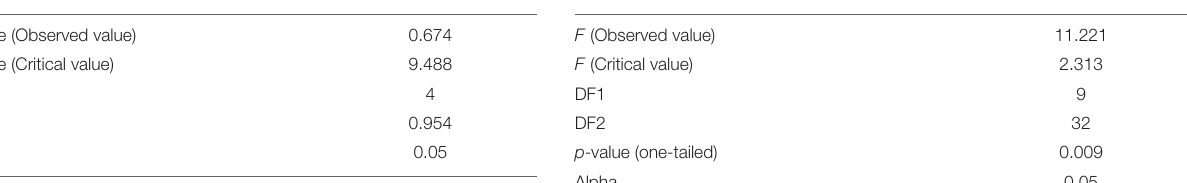
TABLE 2 | Results of Chi-Square test of independence. TABLE 3 | Levene’s